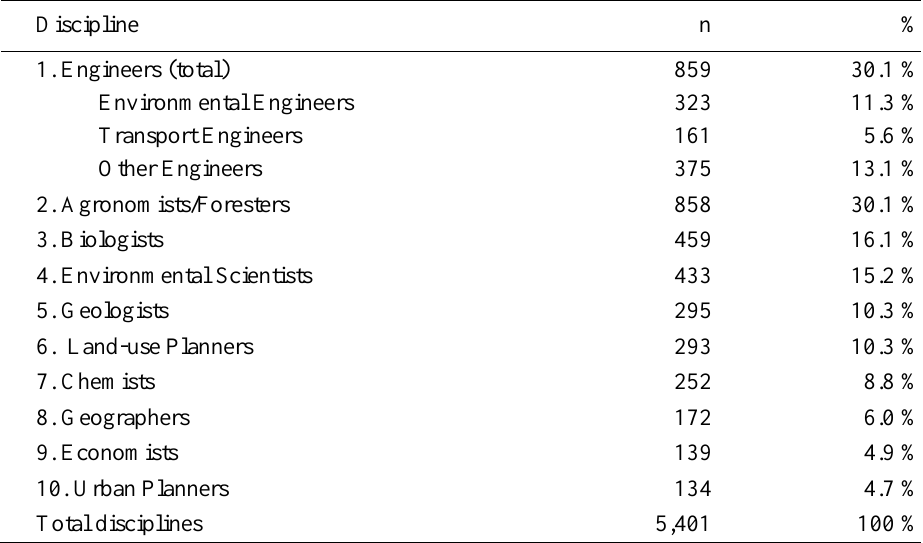
Most common disciplines (multiple responses allowed)